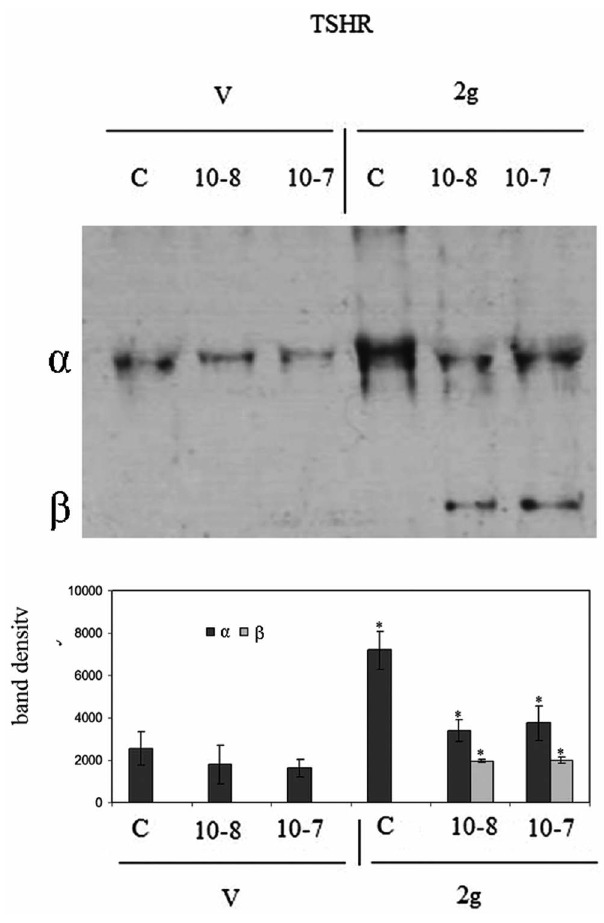
Figure 1. Effect of thyrotropin stimulation on thyrotropin receptor in hypergravity. Thyrotropin receptor in the thyroid tissue of vivarium (V) and 2 gravity (2 g) mice treated or not with 10 2 7 or 10 2 8 thyrotropin (TSH). a) 53 kDa apparent molecular weight of a subunity and 30 kDa of b subunity was indicated in relation to the position of molecular size standard; b) The area density was evaluated by densitometry scanning and analysed with Scion Image programme. The experiment was performed in right lobes of thyroid glands. Data represent the mean 6 S.D. of 7 2 g mice and 6 V mice. Significance, *P , 0.001 2 g versus V